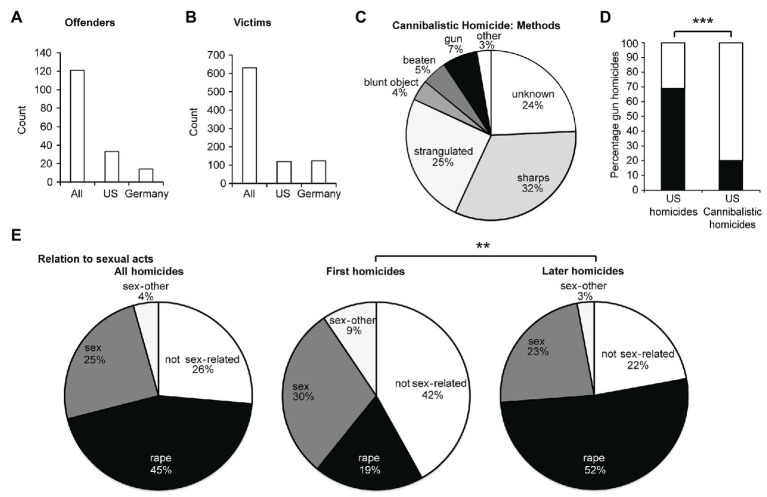
Rate, killing methods, and relation to sexual acts of cannibalistic homicides. (A) Offender numbers in our sample. (B) Victim numbers in our sample. All homicide victims of cannibalistic offenders are plotted, numbers refer to best estimates as defined in the methods. (C) Incidence of killing methods in cannibalistic homicide. (D) Fraction of US homicides and US cannibalistic homicides performed with guns (Fox, 1975). Conventional homicides in the US were more often performed with guns than cannibalistic homicides in the US [X
2(1) = 69.8, p < 0.001]. (E) Relation of cannibalistic homicides to sexual acts in all homicides by cannibalistic offenders (left), their first homicides (middle), and their later homicides (right). There was a significant difference between first and later homicides [X
2(3) = 9.4, p = 0.002].